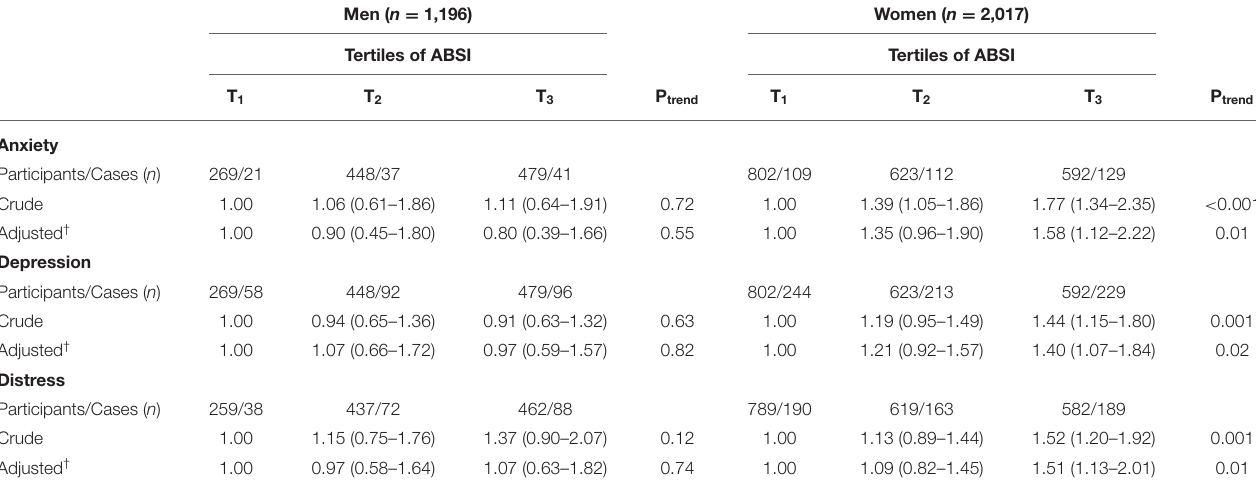
TABLE 5 | Multivariable- adjusted odds ratio for anxiety, depression and distress across tertiles of ABSI, stratified by sex a . Men ( n =